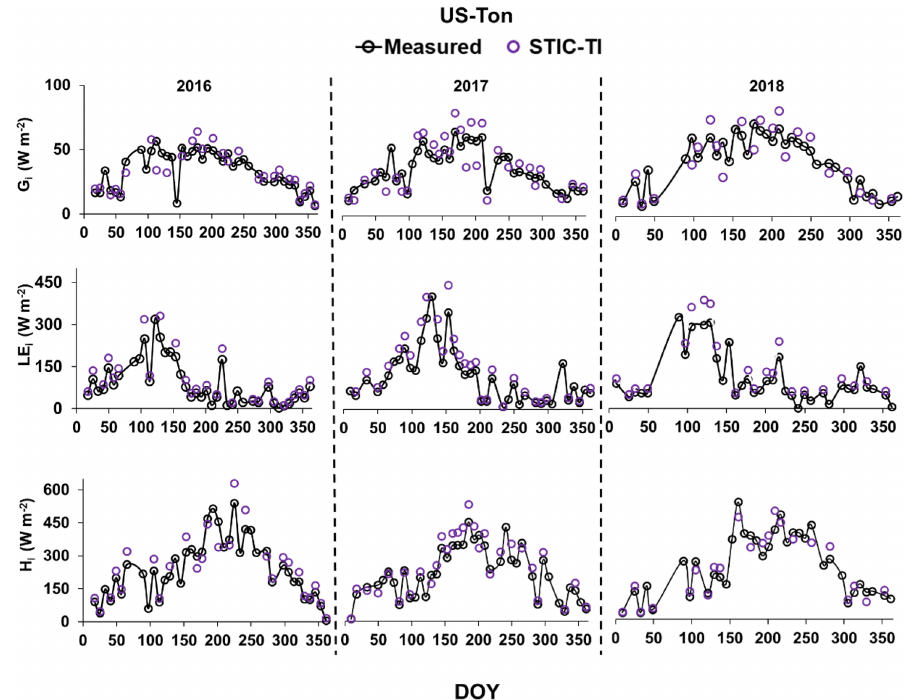
Figure 11. Illustrative examples of the temporal evolution of STIC-TI-derived fluxes using the MYD11A2 LST product versus observed SEB fluxes for 3 consecutive years from 2016 to 2018 in a woody savanna ecosystem in the United States (e.g., US-Ton).